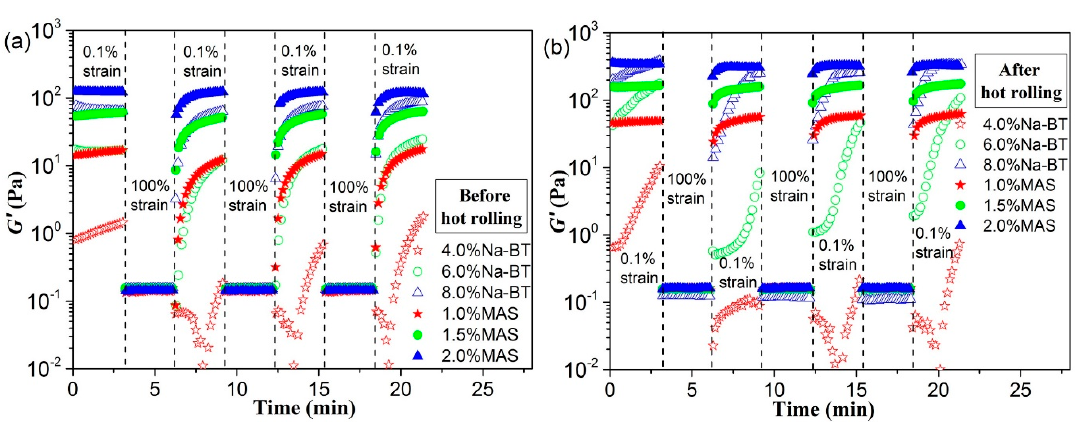
Table 2. Plastic viscosity and yield point of hydrophilic gilsonite nanoparticles (HGN) before and after hot rolling at 422 K [128].